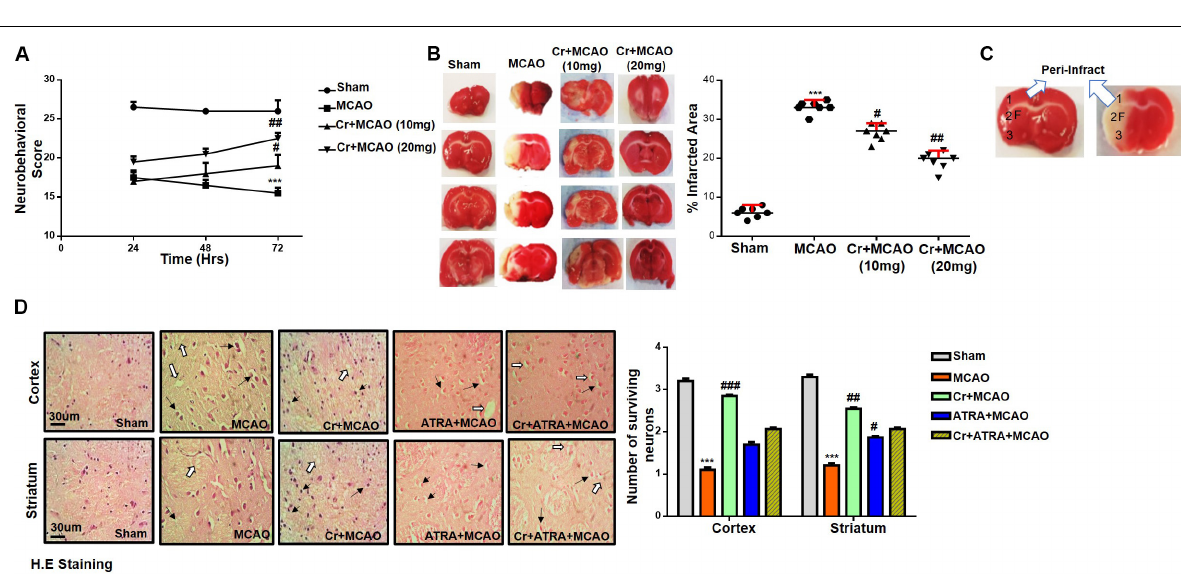
Frontiers in Neuroscience | www.frontiersin.org